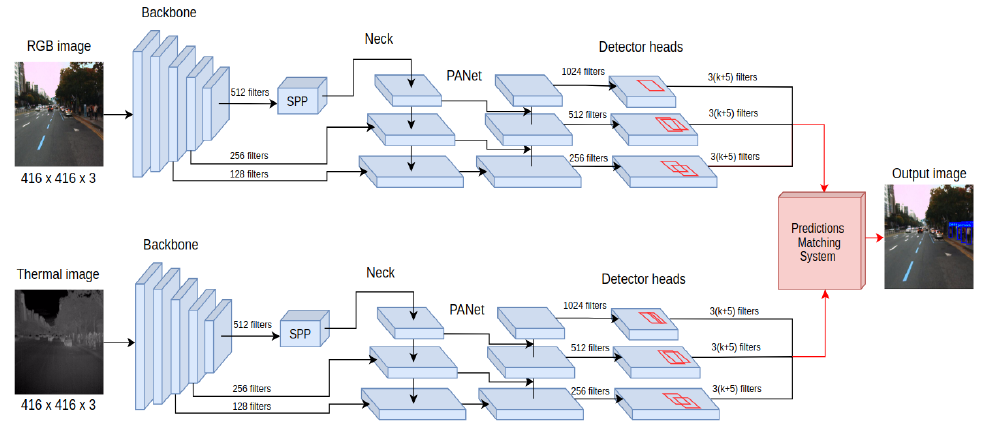
Figure 4. The scheme shows the YOLO4-Late detector architecture, using a prediction matching system to provide unified pedestrian detections based on the inputs of both network branches.